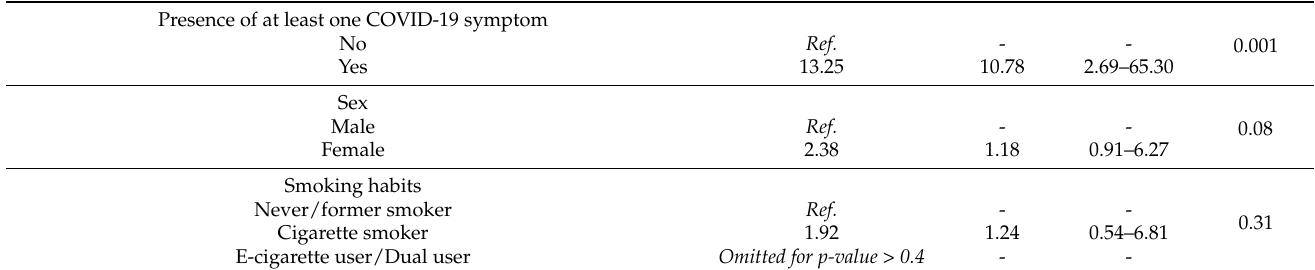
Presence of at least one COVID-19 symptom 0.001No